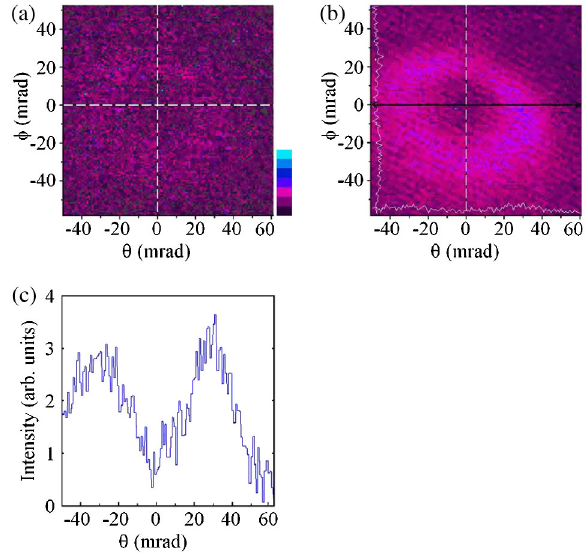
FIG. 2. (a) Spatial distribution of CTR at R ¼ 11 : 0 cm , (b) CTR image summed up to 100 frames, and (c) CTR intensity along the solid arrow in